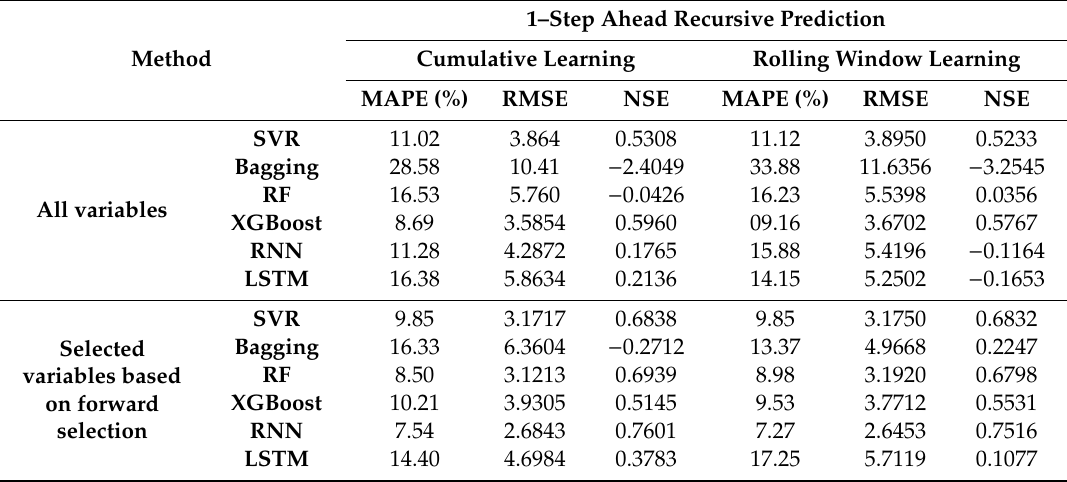
Table 3. Prediction performance of the studied machine learning